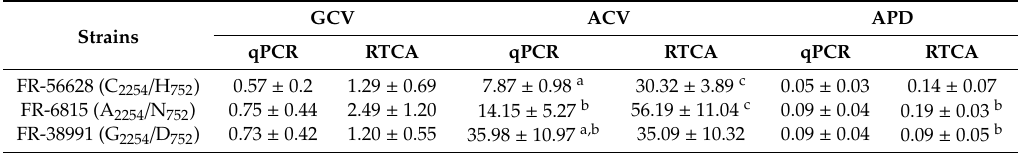
Figure 8. Clinical scores ( A ), pyrexia ( B ), nasal shedding ( C ) and viraemia ( D ) observed from − 3 days to 21 days post-infection with EHV-1 strain FR-56628 in four Welsh ponies. Table 4. EC 50 ( µ M) ± standard deviation (SD) of ganciclovir (GCV), aciclovir (ACV) and aphidicolin (APD) against three di ff erent EHV-1 ORF30 2254 variants measured by qPCR assays and real time cell analysis